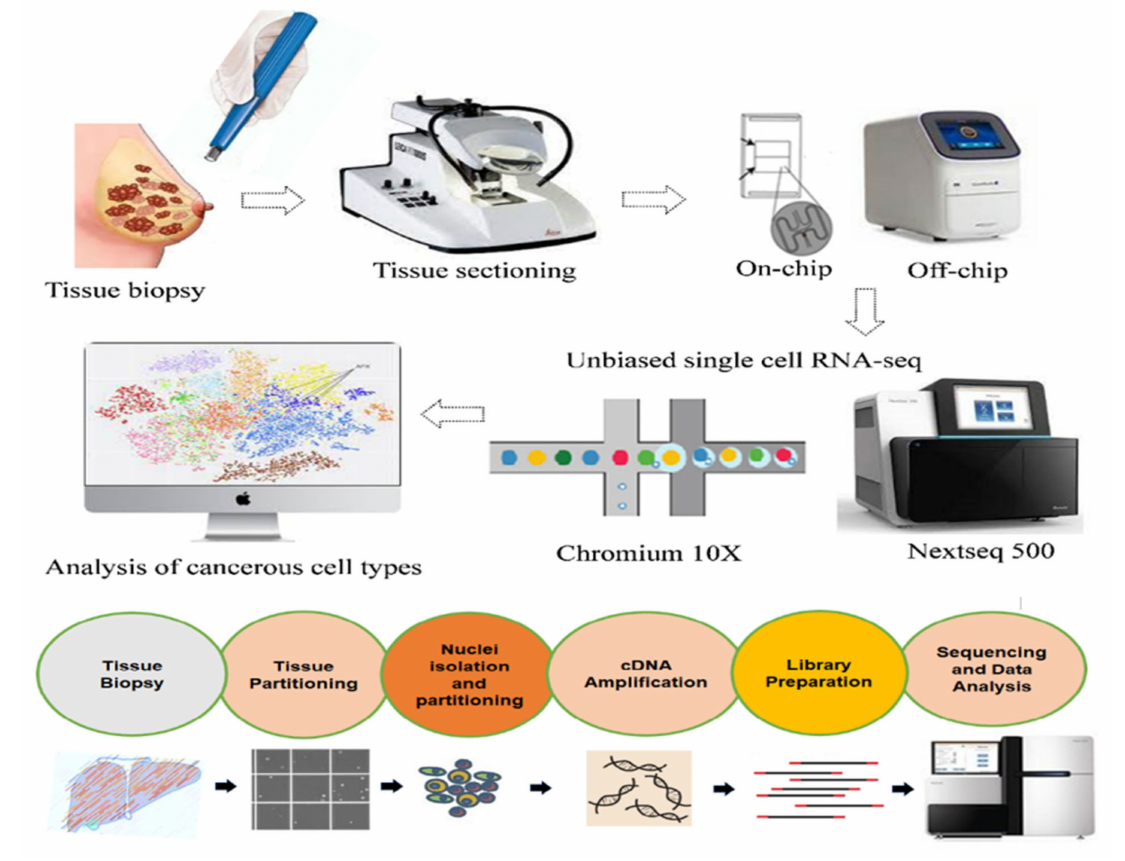
Figure 2. A schematic of various steps used for the analysis of biopsy tissue samples by RNA-seq techniques such as isolation and sequencing of single cells, preparation of RNA library, and single-cell level transcriptome